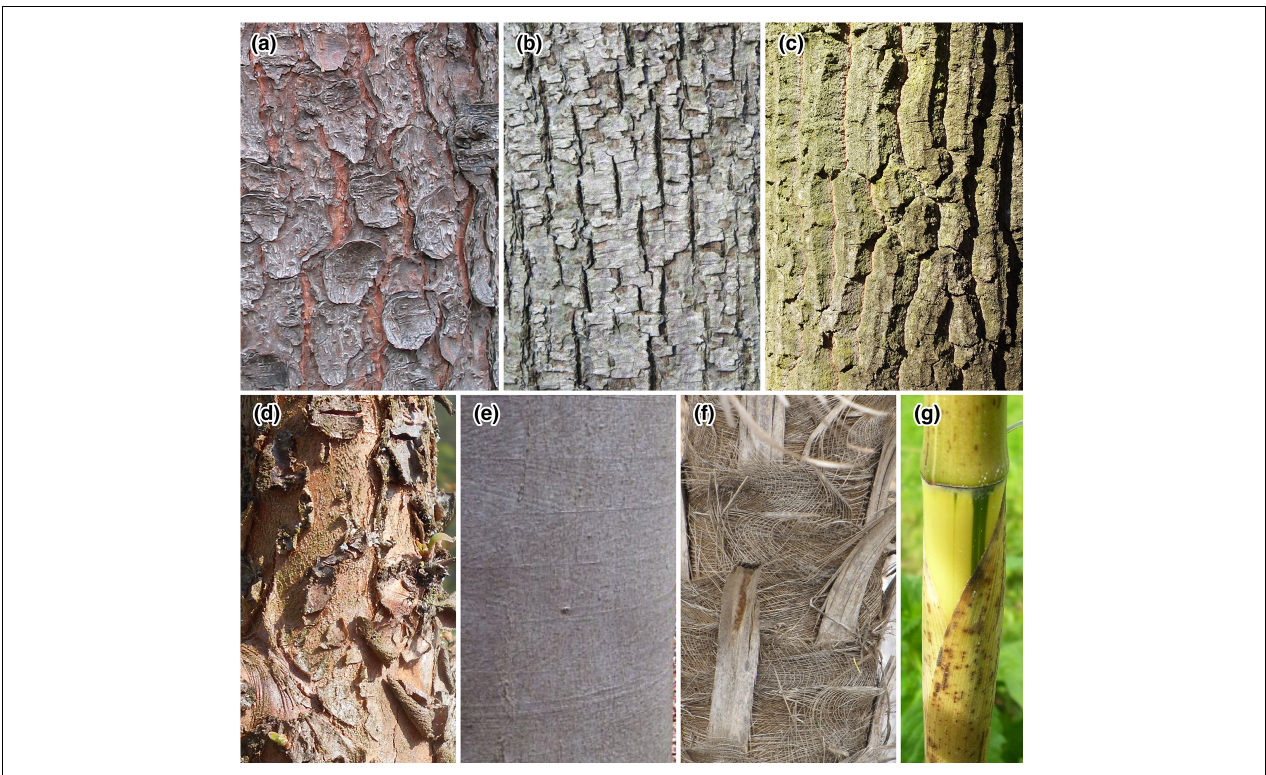
FIGURE 1 | Bark types included in studies to-date examining fungal conidia assemblages in stemflow, bark or honeydew: (a) scaled or plated bark, e.g., Picea abies (Kwiecie´n, 2005); (b) fissured bark, e.g., Tilia cordata (Havelaar, 2020); (c) ridged bark, e.g., Quercus cerris (Lefnaer, 2016); (d) flaked or exfoliating bark, e.g., Metasequoia glyptostroboides (Salicyna, 2017); (e) smooth bark, e.g., Fagus sylvatica (Elsner, 2012); (f) palm “pseudobark,” e.g., Coccothrinax barbadensis (Starr and Starr, 2009); and (g) bamboo culm, e.g., Phyllostachys vivax (Hanfmampf,